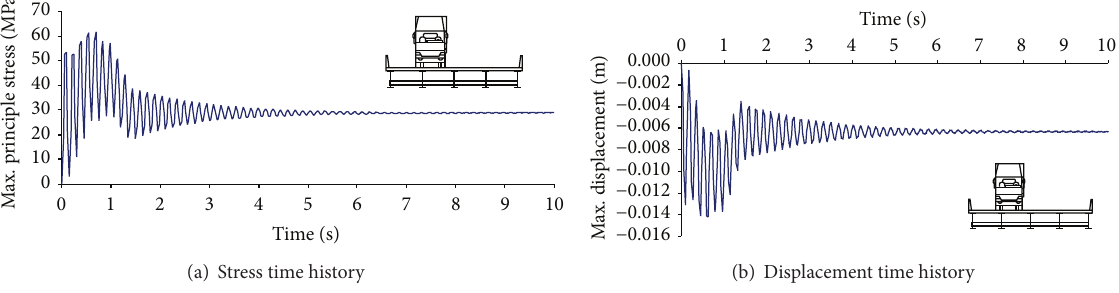
Figure 11: An example of dynamic responses extracted from the FE analysis.